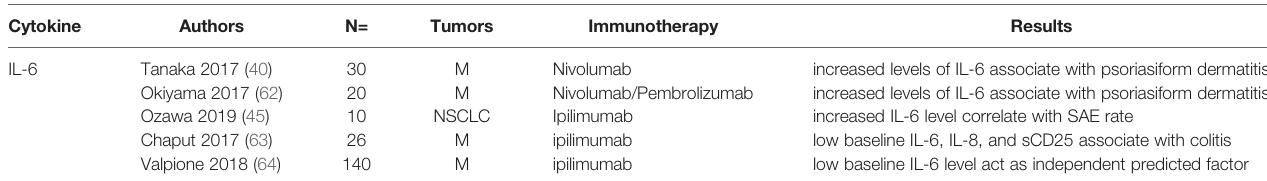
TABLE 2 | Clinical studies of the association of ICT irAEs with cytokines.